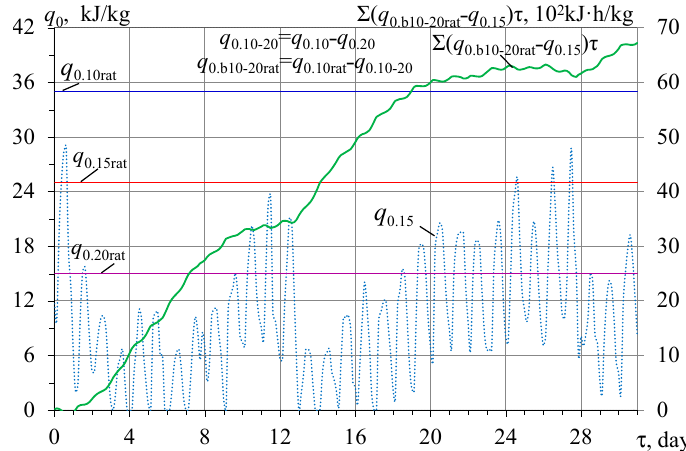
Figure 6. Current values of specific thermal load q 0.15 for cooling ambient air to t a 2 = 15 °C and summarized excesses of available accumulated boost refrigeration energy Σ ( q 0.b10-20rat − q 0.15 ) τ over required cooling capacities q 0.15 : q 0.b10-20rat = q 0.10rat − q 0.10-20 ; q 0.10-20 = q 0.10 − q 0.20 .